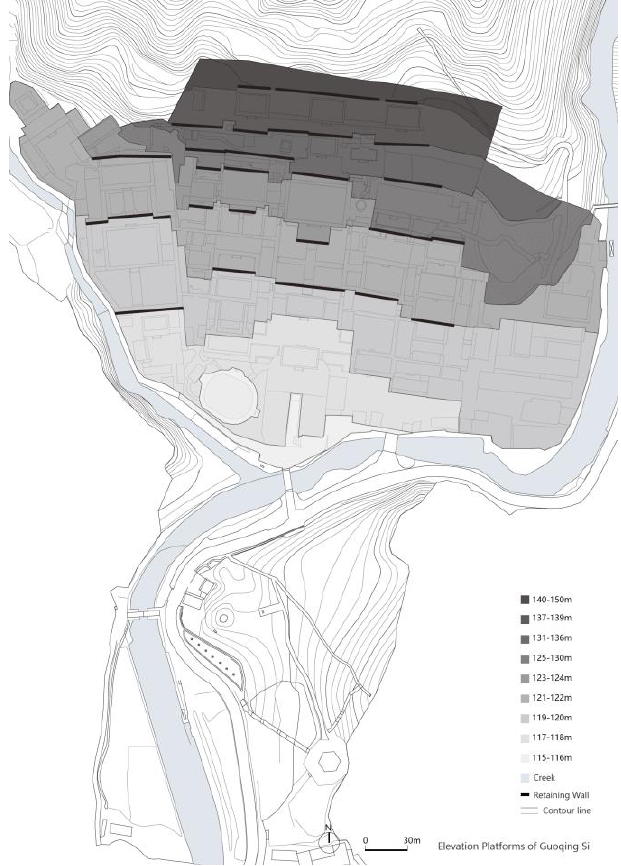
Figure 25. Elevation platforms of Guoqing Si.